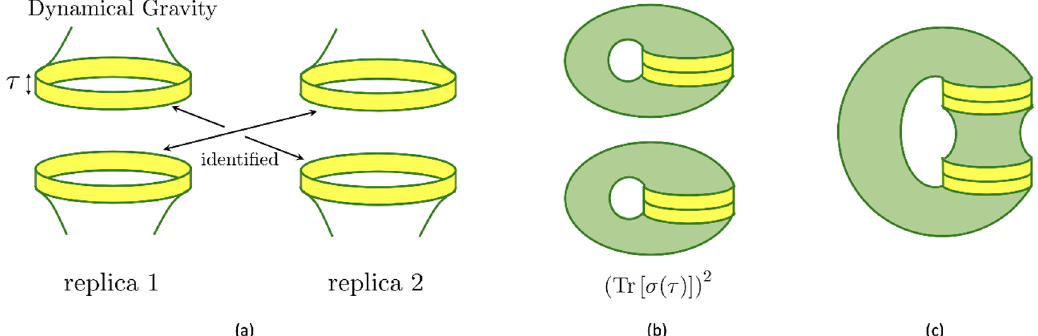
(cid:2) (cid:3) σ ( τ ) 2 , where we fix the boundary conditions in